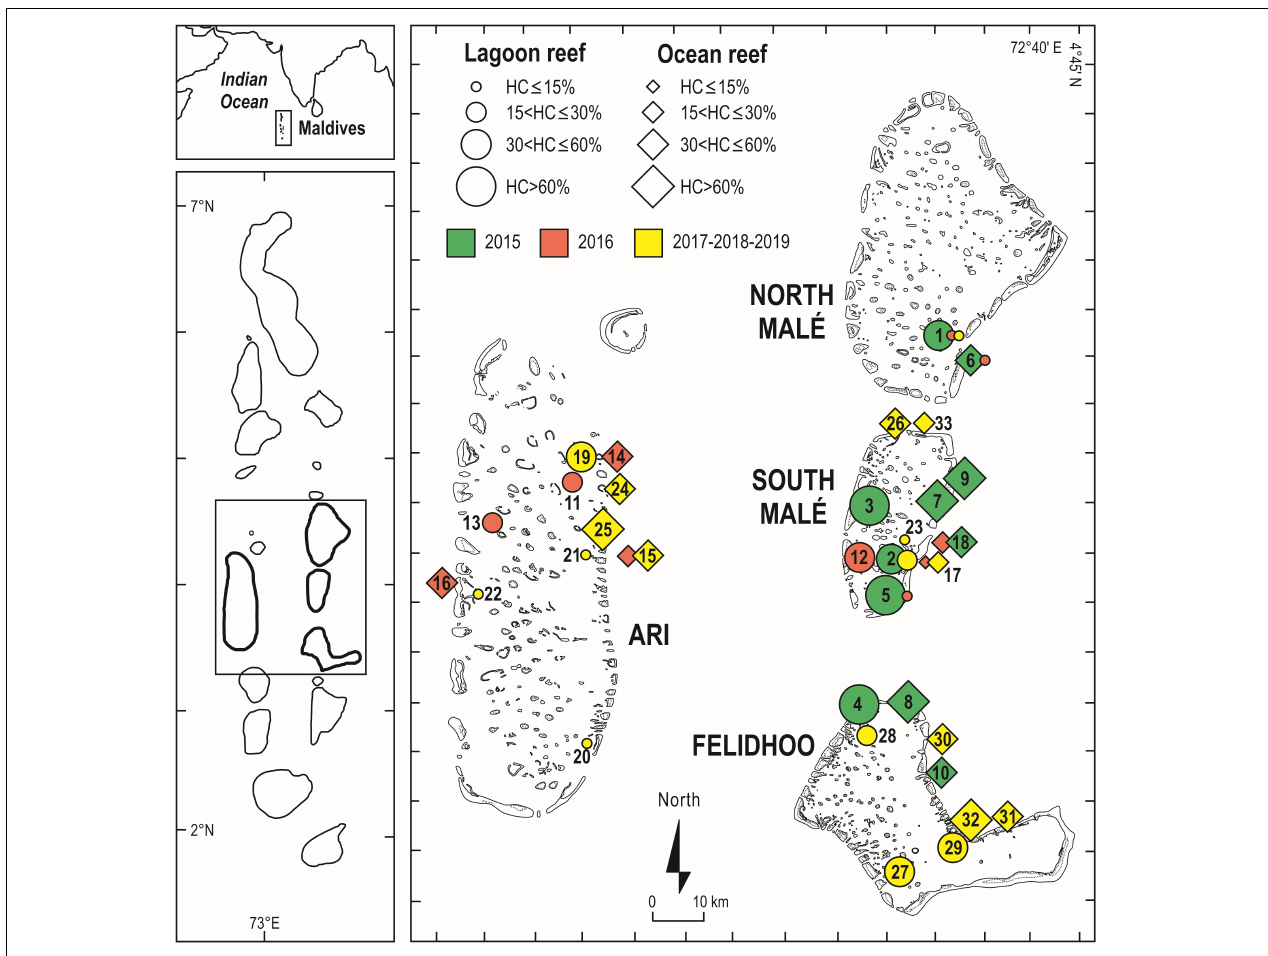
FIGURE 4 | Geographical setting of the Maldives Archipelago and of the central atolls surveyed in recent years, with the mean percent cover of live hard corals at shallow reefs (5 m depth) in the 51 reefs surveyed during the 2015, 2016, 2017, 2018, and 2019 scientific cruises. Each reef is labeled according to the codes reported in Supplementary Table S2 . In green are the reefs surveyed before the 2016 mass bleaching event (i.e., the pre-bleaching year in 2015), in red are the reefs surveyed during the bleaching event (in 2016), and in yellow are the sites surveyed after the bleaching event. For a safe of clarity the post-bleaching year (in 2017) and the years of early recovery (2018 and 2019) are grouped in this figure. North Malé and South Malé are atolls affected by high human pressure, whilst Ari and Felidhoo atolls by low human pressure.